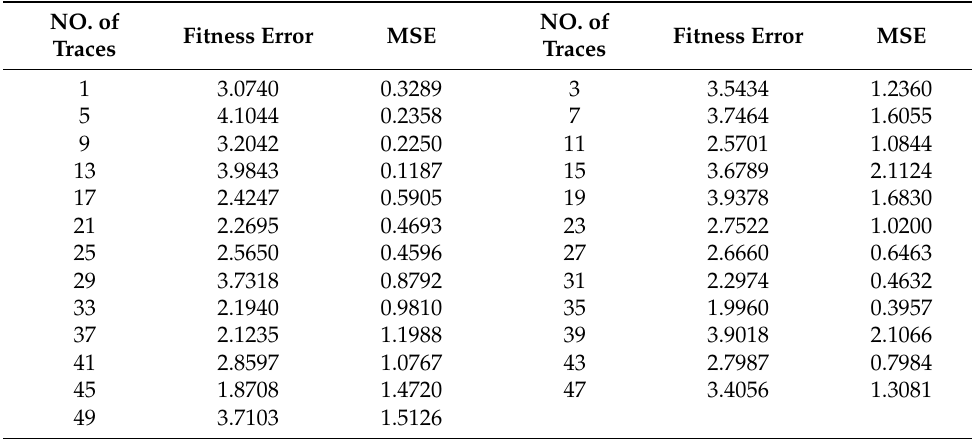
Table 2. Fitness error and MSE of the single-trace PSO process.